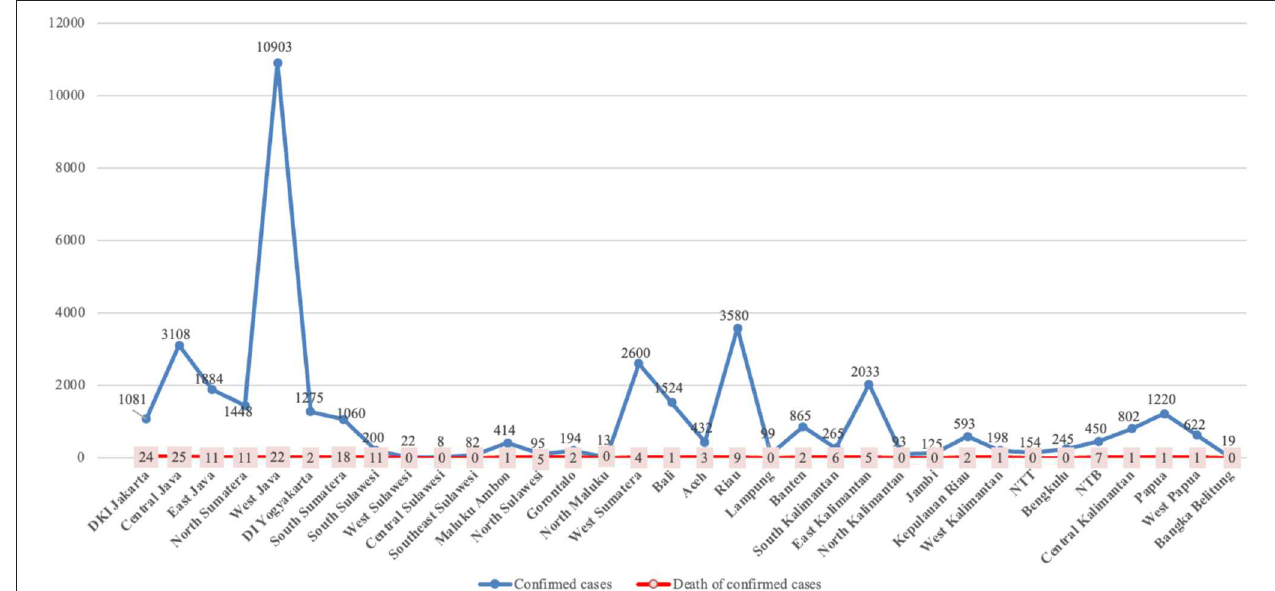
FIGURE 2 | Distribution of confirmed COVID-19 cases according to region of origin.